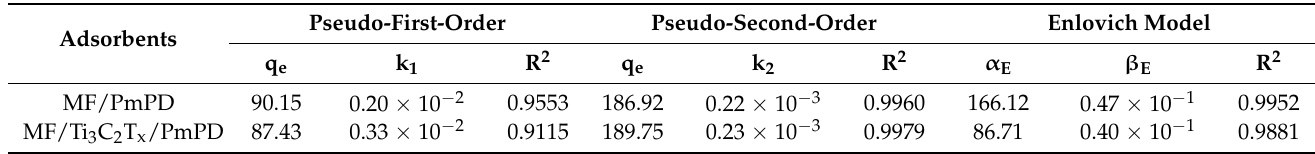
Figure 10. Linear fitting of pseudo-first-order ( a ), pseudo-second-order ( b ) and Enlovich ( c ) models of Cr(VI) adsorption by MF/PmPD and MF/Ti 3 C 2 T x /PmPD. Table 3. Correlation coefficient of pseudo-first-order, pseudo-second-order and Enlovich kinetic models fitting.